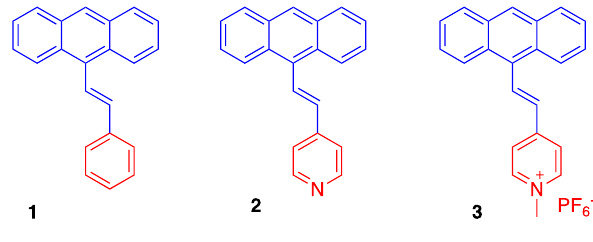
Figure 2. Chemical structures of dyes 1 – 3 .